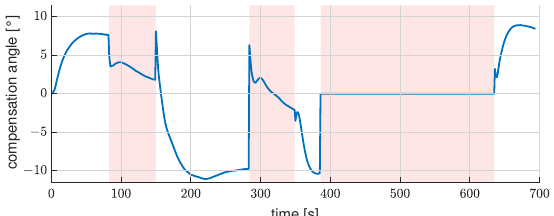
Figure 19. Heading compensation amount. The amount of heading compensation for each course track during navigation, which is zero when sailing up-wind because there is no reference track.